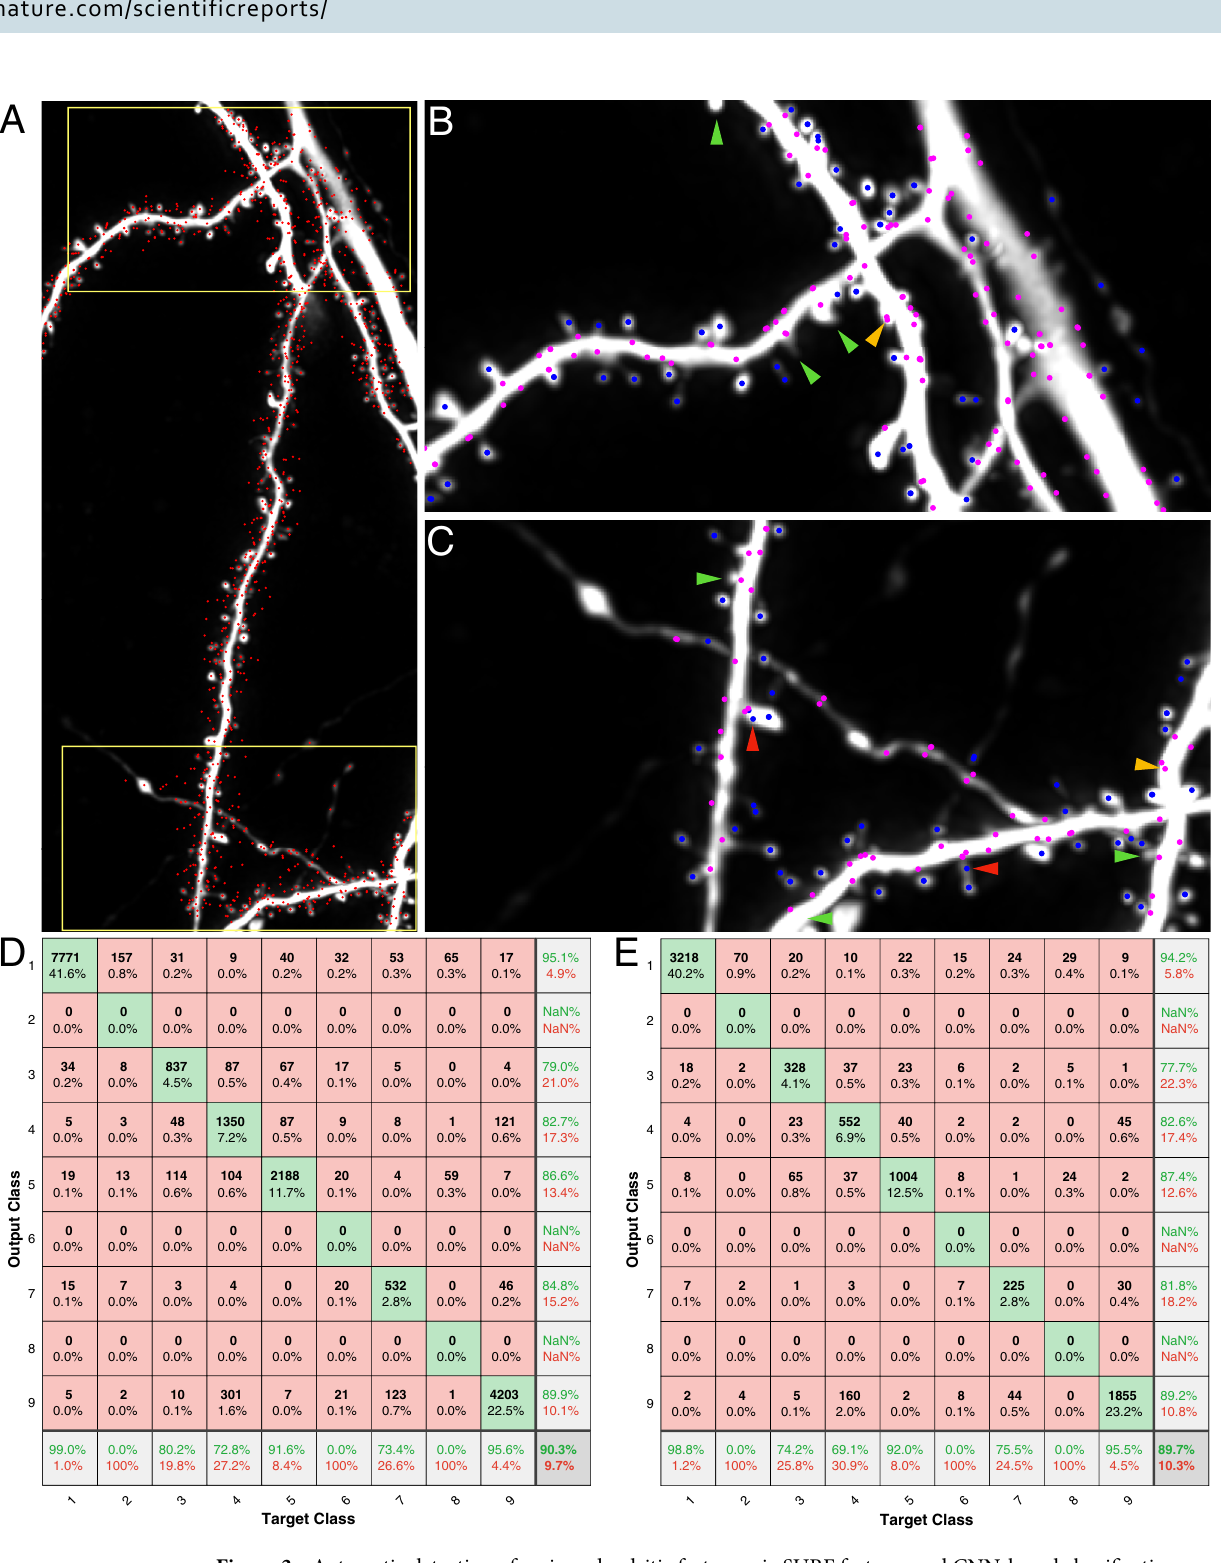
Figure 3. Automatic detection of various dendritic features via SURF features and CNN-based classification. ( A ) Candidate SURF locations are marked with red dots. 3.395 × 3.395 µ m 2 ROIs around each SURF location are fed into the dendritic feature classification network (CNN). ( B,C ) The network has 9 output classes. Here we show two of the classes: Dendritic spines in blue and dendrite edges in magenta. Green arrows show undetected spines. Red arrows are misdetections and yellow arrows are misclassifications. ( D ) Confusion matrix for the training dataset. ( E ) Confusion matrix of the test dataset. Classes are 1: spines, 2: multiple overlapping spines, 3: spine neck base, 4: dendrite edge, 5: dendrite, 6: spine neck, 7: spine head edge, 8: bouton/axon (some datasets contained these structures as well), 9: